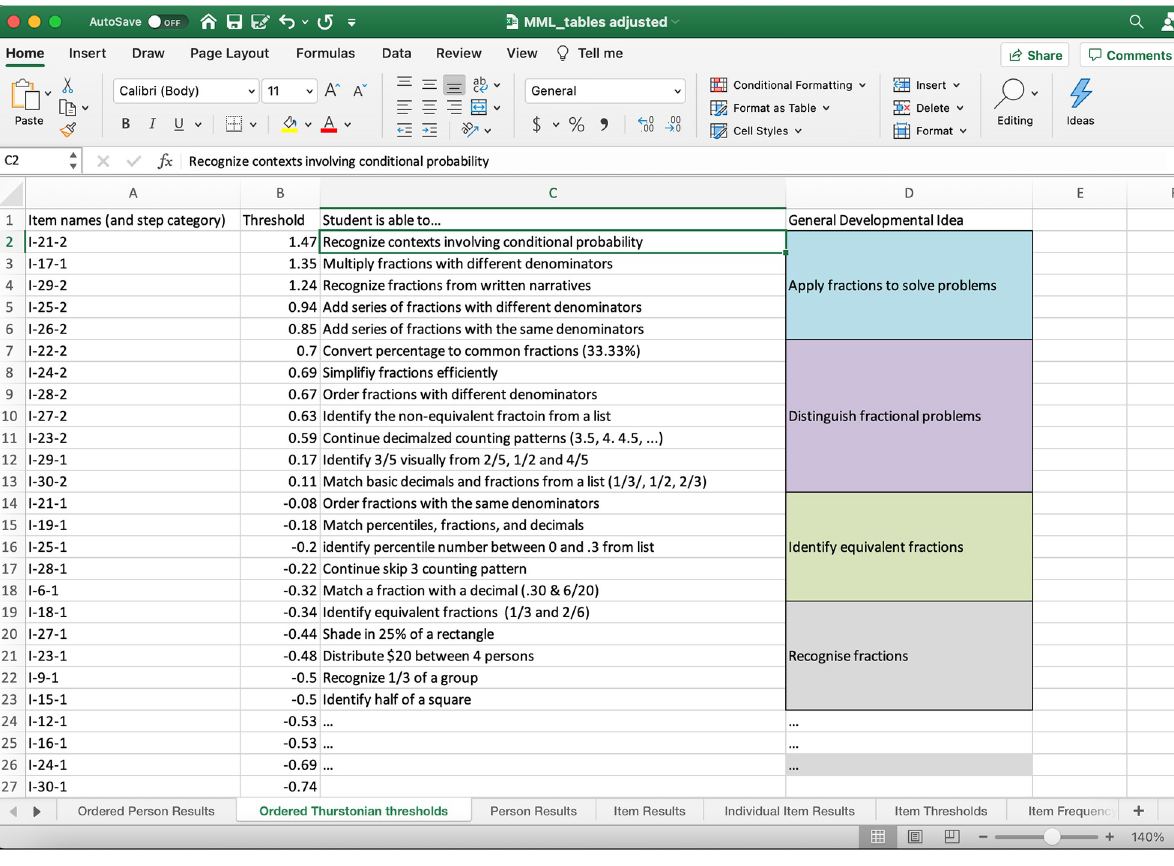
Fig 8. Entering developmental descriptors for item categories. Note. Based upon an analysis of the skills necessary to complete the questions, app users can complete columns C pertaining to the skill associated with each question item of step, and may also like to categorise general developmental ideas, as in column D.